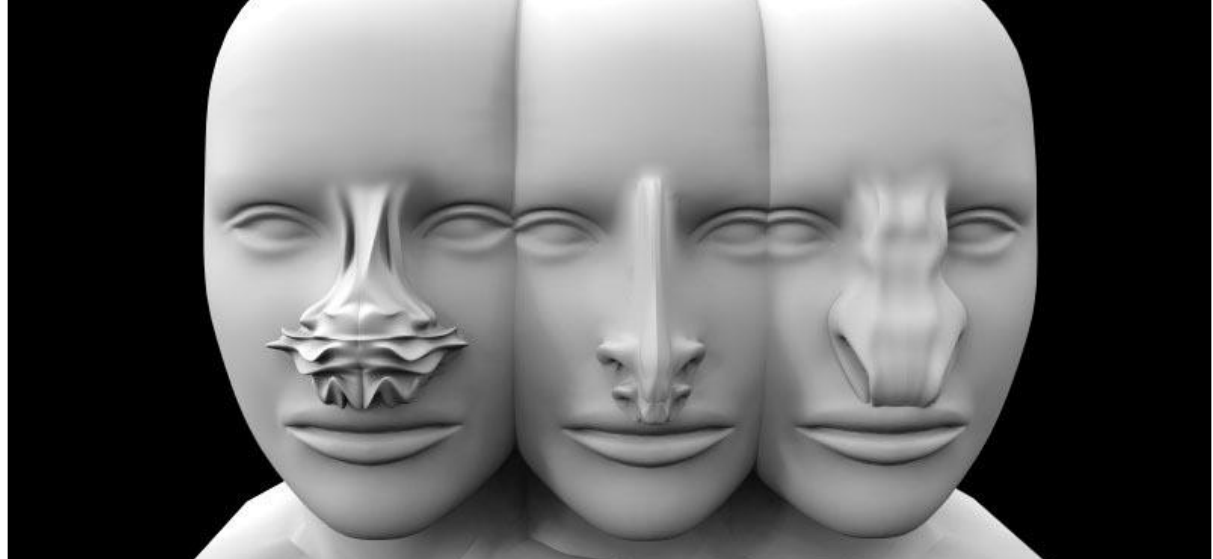
Figure 1 | Visualisation of speculative